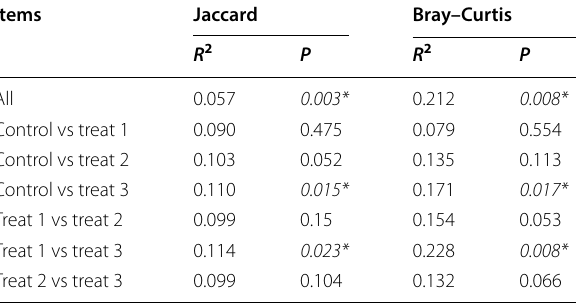
showing different